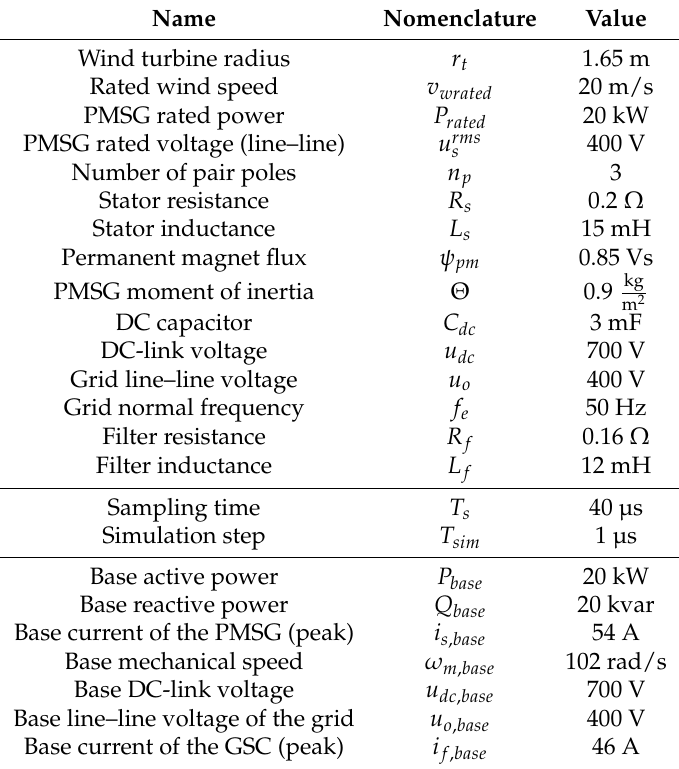
Table 1. Parameters of PMSG-based